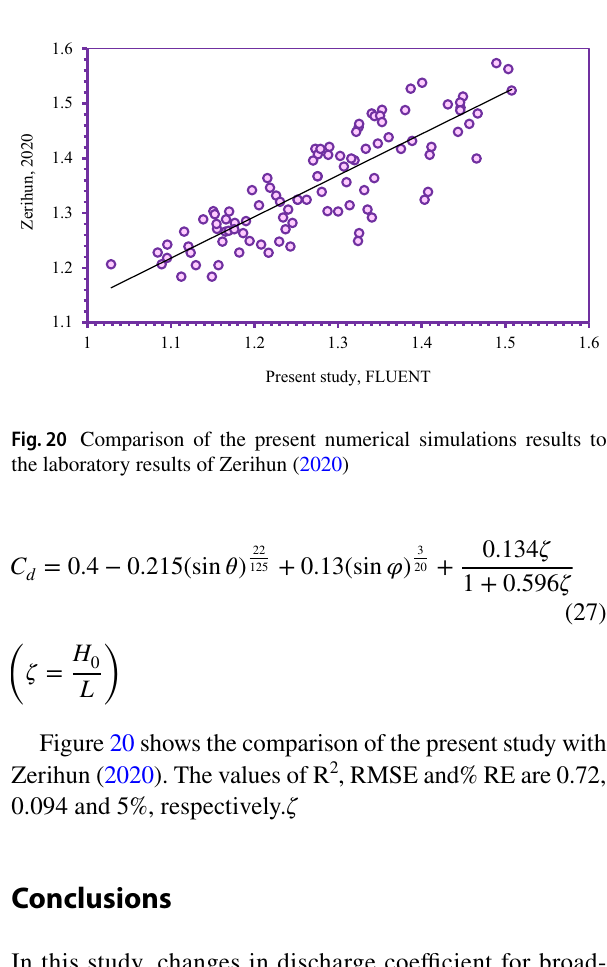
Fig. 19 Comparing the numerical simulation results in present study and laboratory results of Bijankhan et al. (2013)